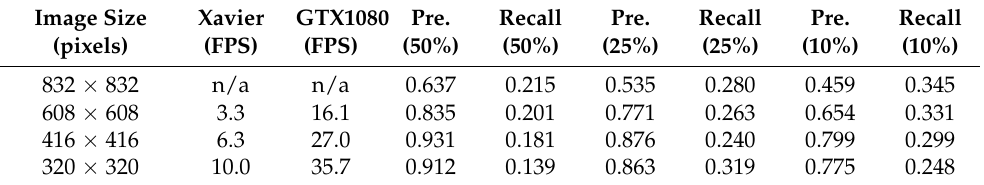
Table 7. Frame rate (FPS) vs. precision and recall with a confidence threshold of 10%, 25% and 50% of the trained YOLOv3 model running on the Jetson AGX Xavier platform or a Ubuntu computer equipped with an Nvidia GTX1080